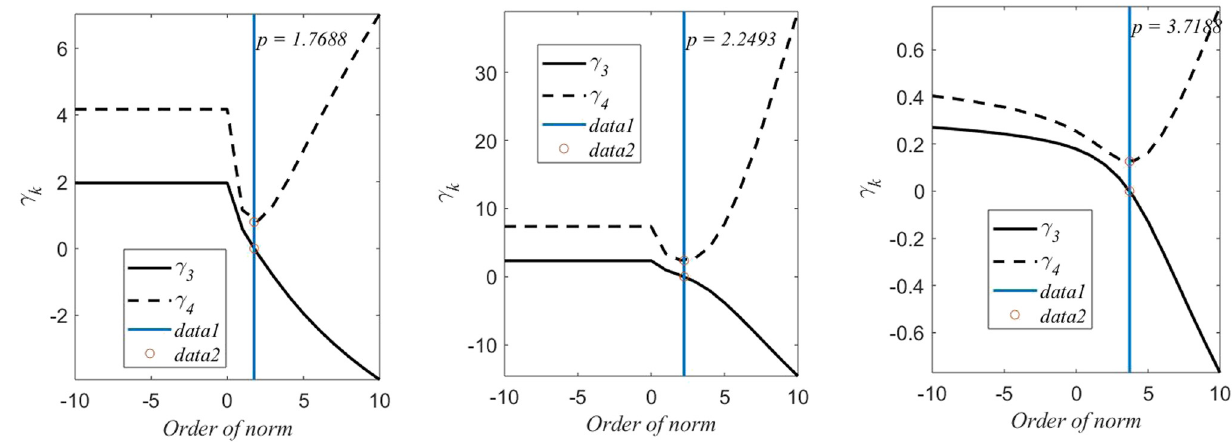
Figure 11: Analysis of parameters for the new con fi rmed deaths in